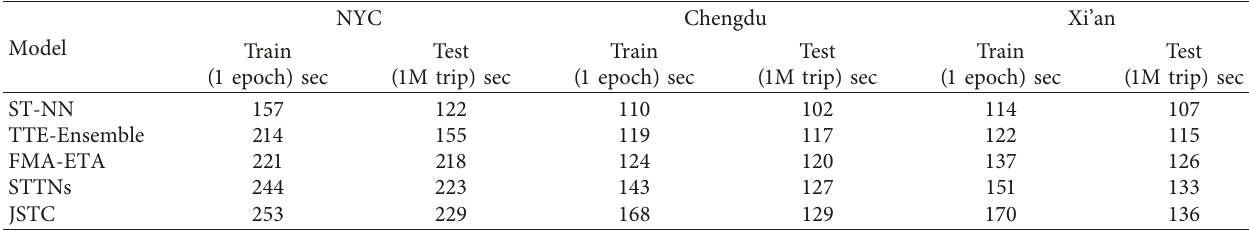
Table 7: Comparison of time consumption of different models on all